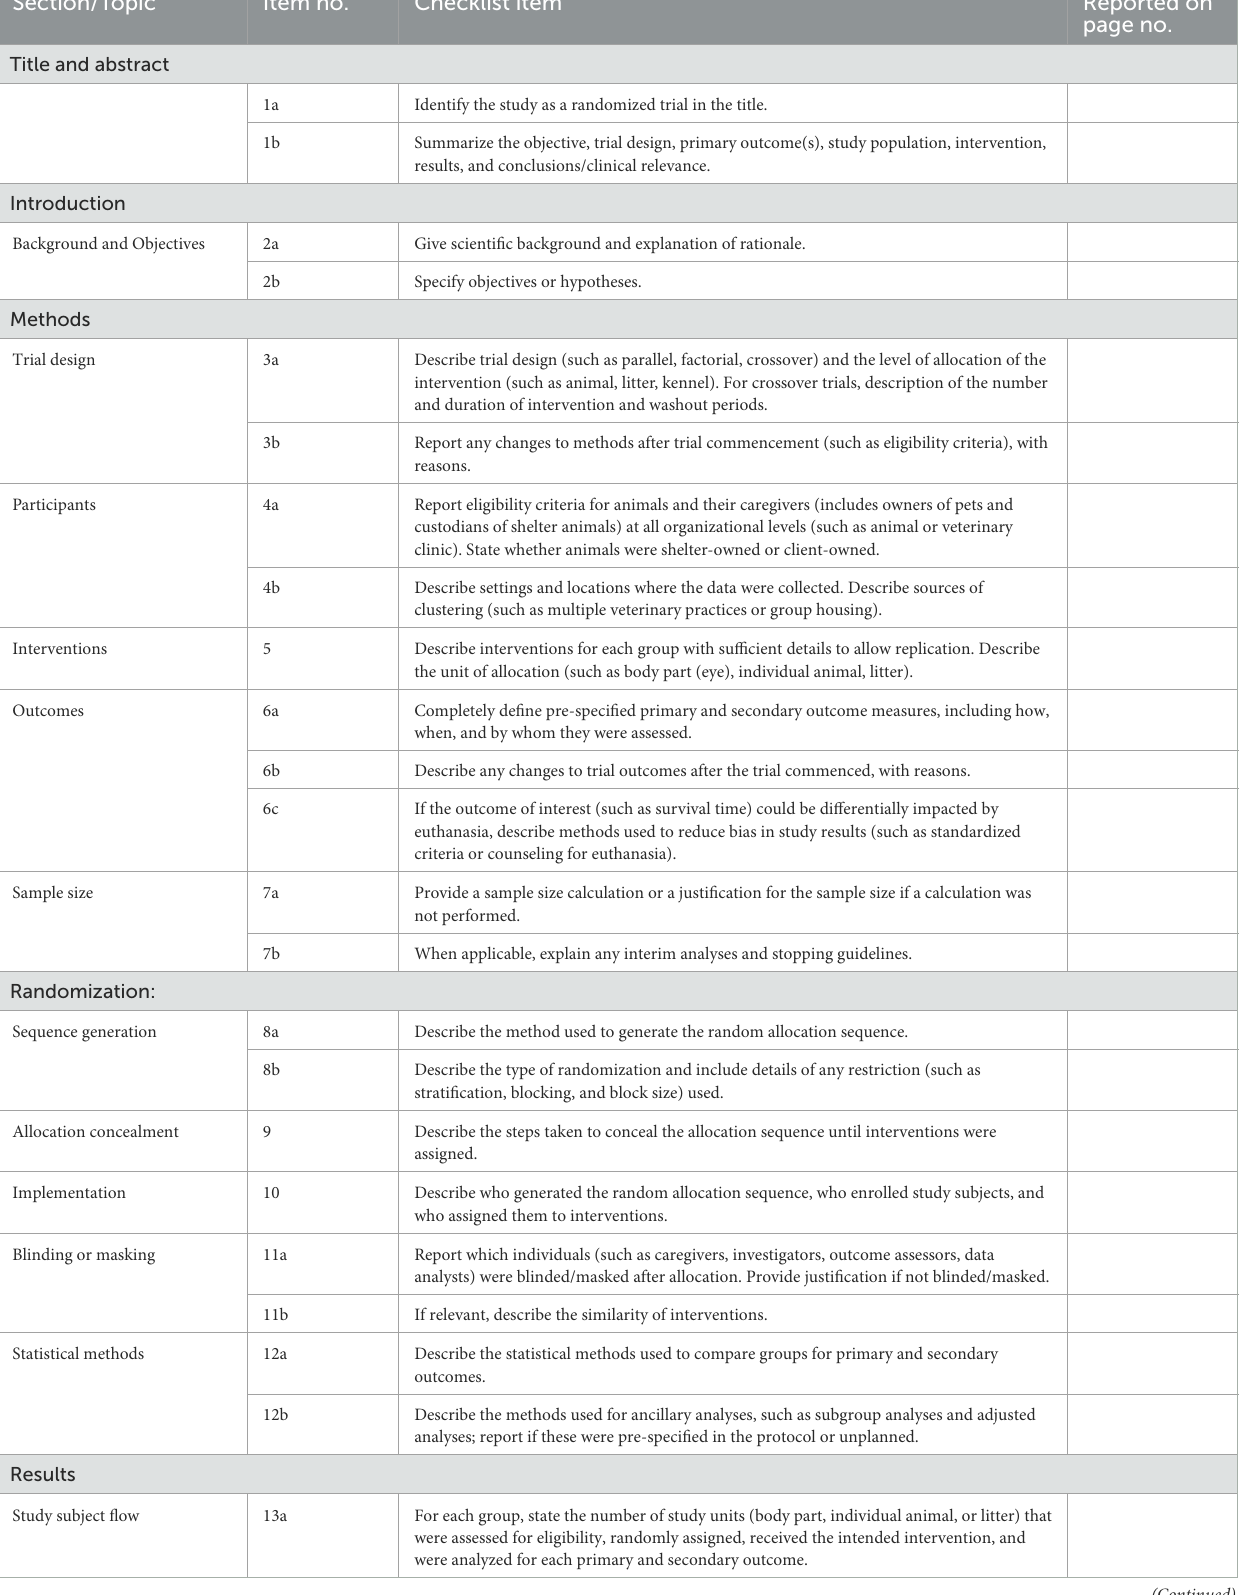
TABLE 1 PetSORT checklist of information to include when reporting a randomized trial.